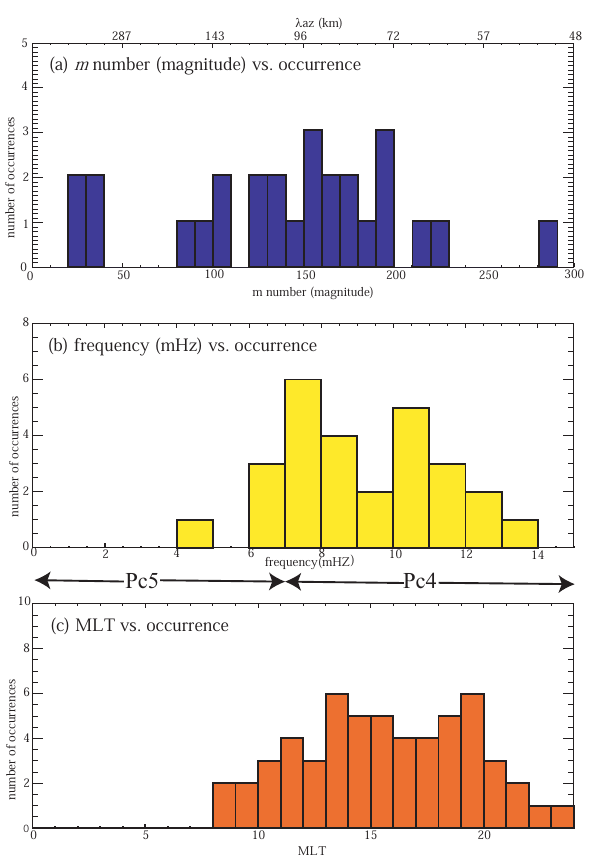
Fig. 4. Occurrence statistics of the 27 pulsation events observed by